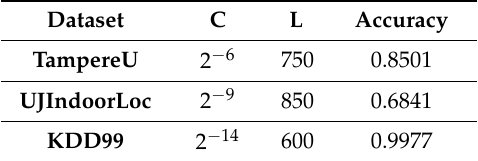
Figure 4. Characterization model represented in mesh for the accuracy relation between the number of hidden neurons and regularization factor. ( a ) TampereU; ( b ) UJIndoorLoc; and ( c ) KDD99 datasets. To extract the values of C and L, the mesh was mapped to C versus the accuracy curve, or L versus the accuracy curve, respectively. The three dataset curves are shown in Figure 5, while the results for L and C that achieved the best accuracy for each of the three models are given in Table 1. Table 1. Selected values for regularization factor regularization factor (C) and number of hidden neurons (L), and their corresponding accuracy for the three datasets.